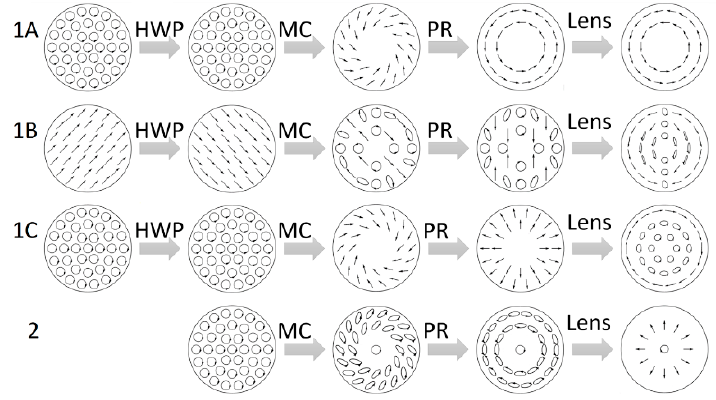
Figure 6. Polarization state after each optical component, for each variation of the system. We also consider the case with QWP and HWP rotated simultaneously in the same direction, with the rotation angle of QWP twice the rotation angle of HWP ( ϕ = 2 γ ). The Jones vector for the